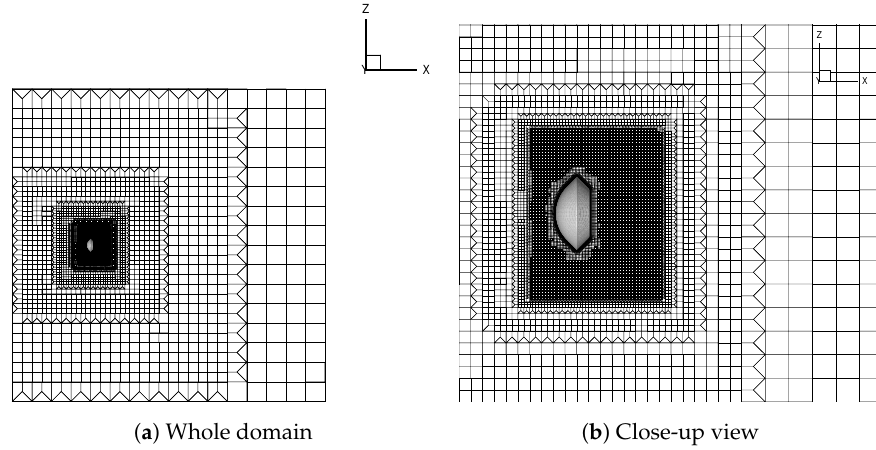
Figure 4. Computational grid on the symmetric